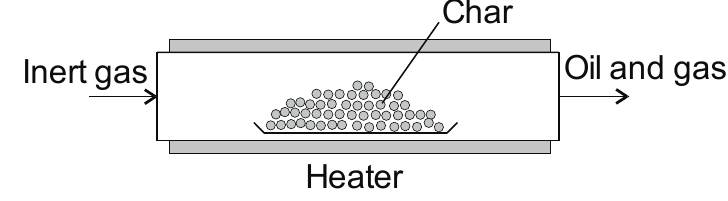
Figure 7. Lambiotte retort.